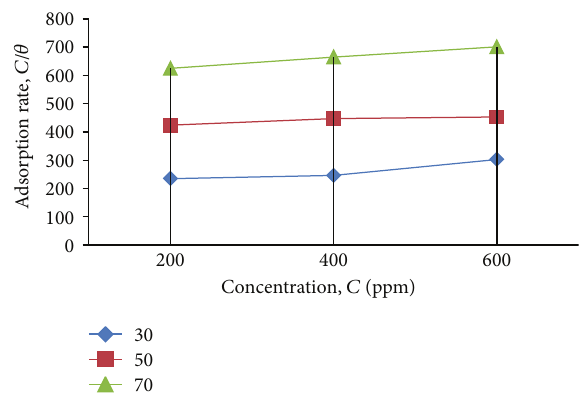
Figure 1: Langmuir adsorption isotherm for Henna/Zeolite powder on mild steel.